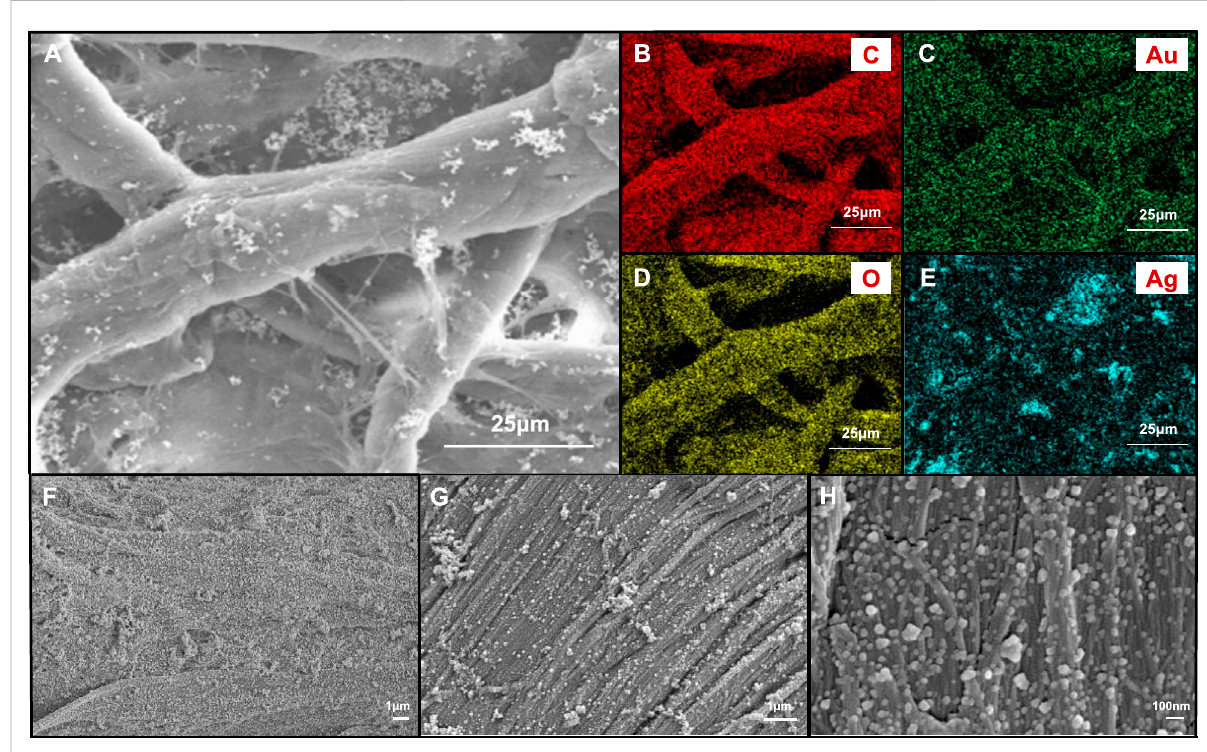
FIGURE 4 (A) FESEM images of Au-Ag 8 -3-FP surfaceand imageswith elemental mappingof (B) C, (C) Au, (D) O, (E) Ag, respectively. FESEM imagesofAu- Ag